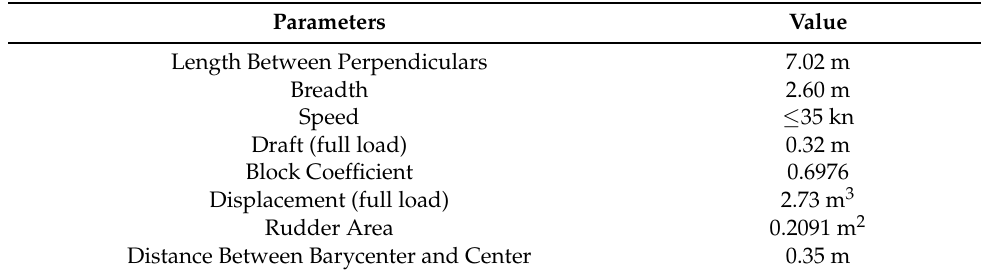
Table 1. The “LanXin” USV